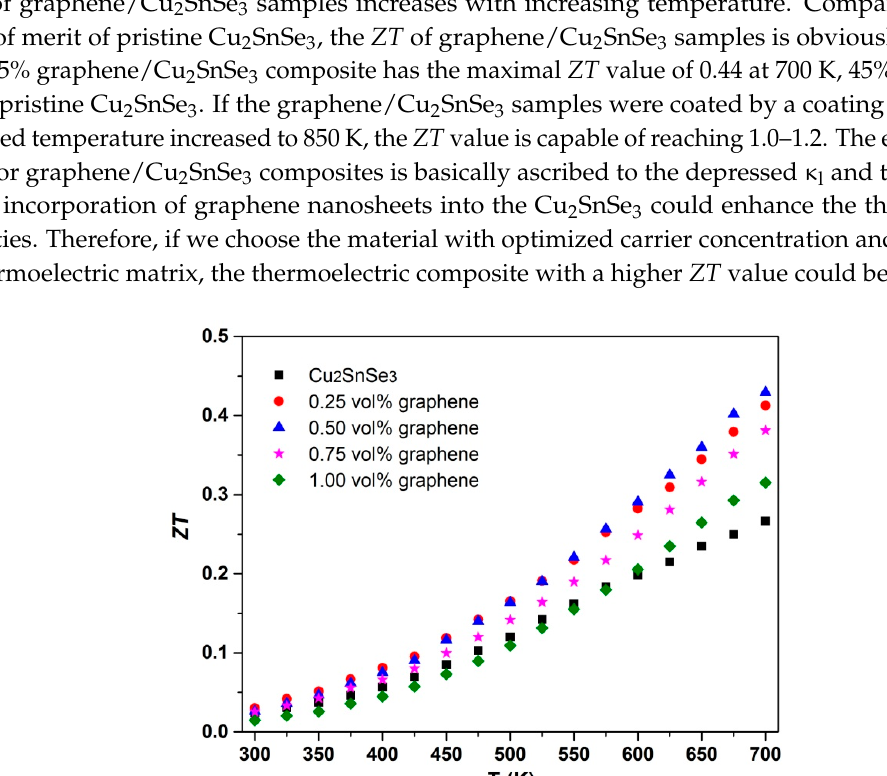
Figure 12. The dimensionless figure of merit of ( ZT ) of graphene/Cu 2 SnSe 3 samples as a function of temperature.